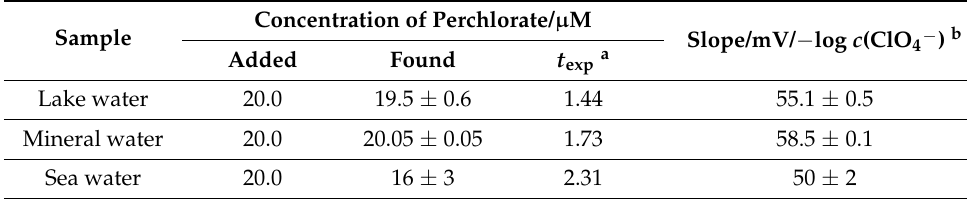
Table 3. Results of real samples analyzed by means of the perchlorate ISE (Table 2—Electrode 7).